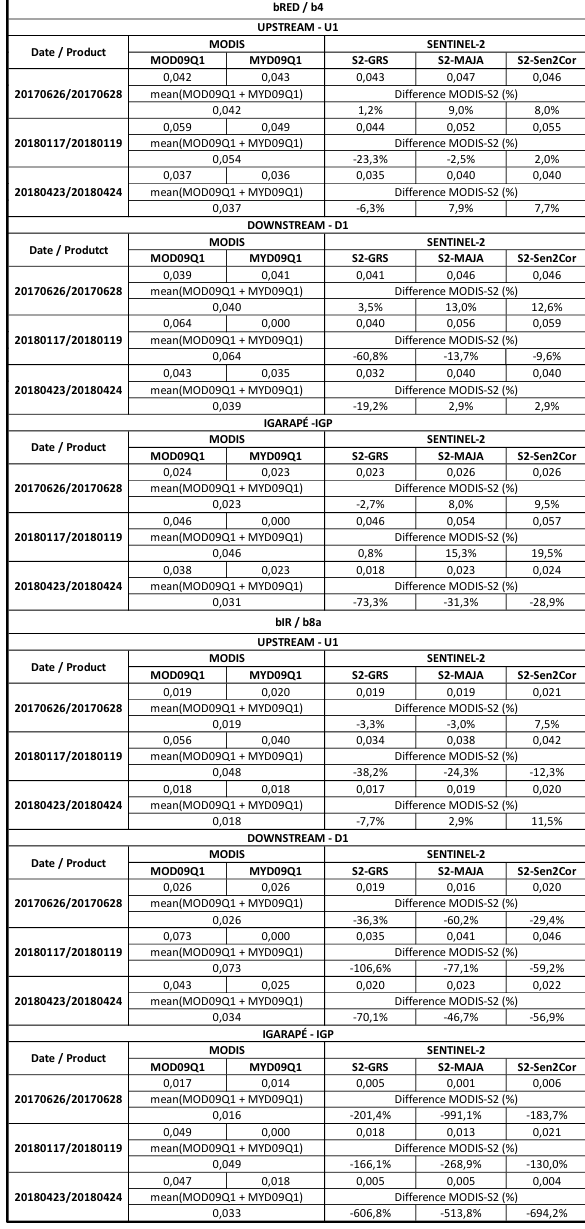
Table 2. Average reflectances values in M1, J1 and IGP regions